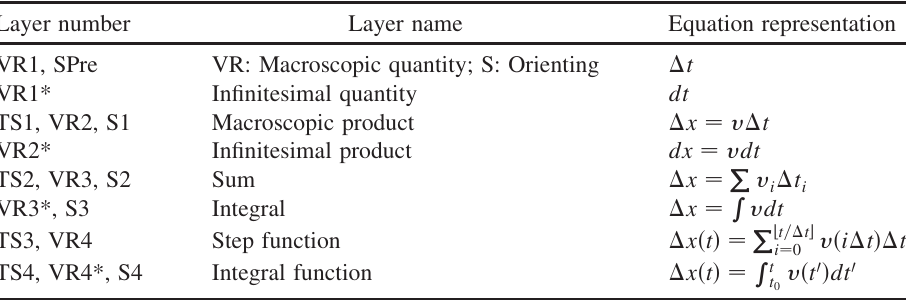
TABLE I. We list all eight of our layers, with corresponding equations. VR indicates Von Korff and Rebello, S indicates Sealey, and TS refers to Thompson and